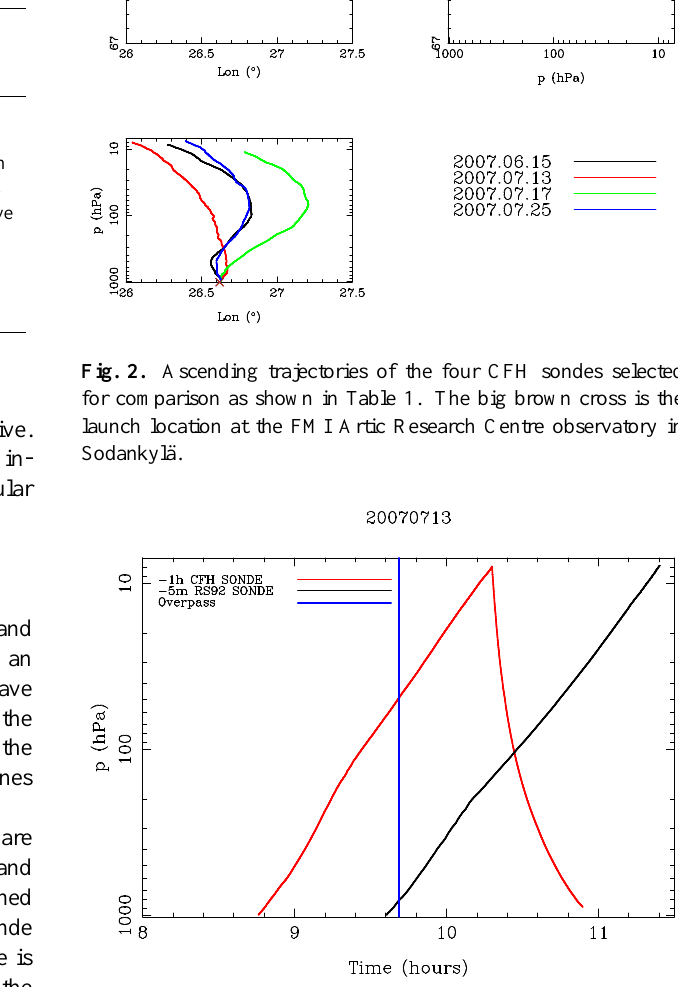
Fig. 3. Vertical position of the sonde versus time. The sonde, which carries an RS92 and a CFH, launched 1h before overpass time is plotted (red) together with the sonde, carrying only an RS92, launched 5min before overpass time (black). The overpass time is plotted as a vertical line